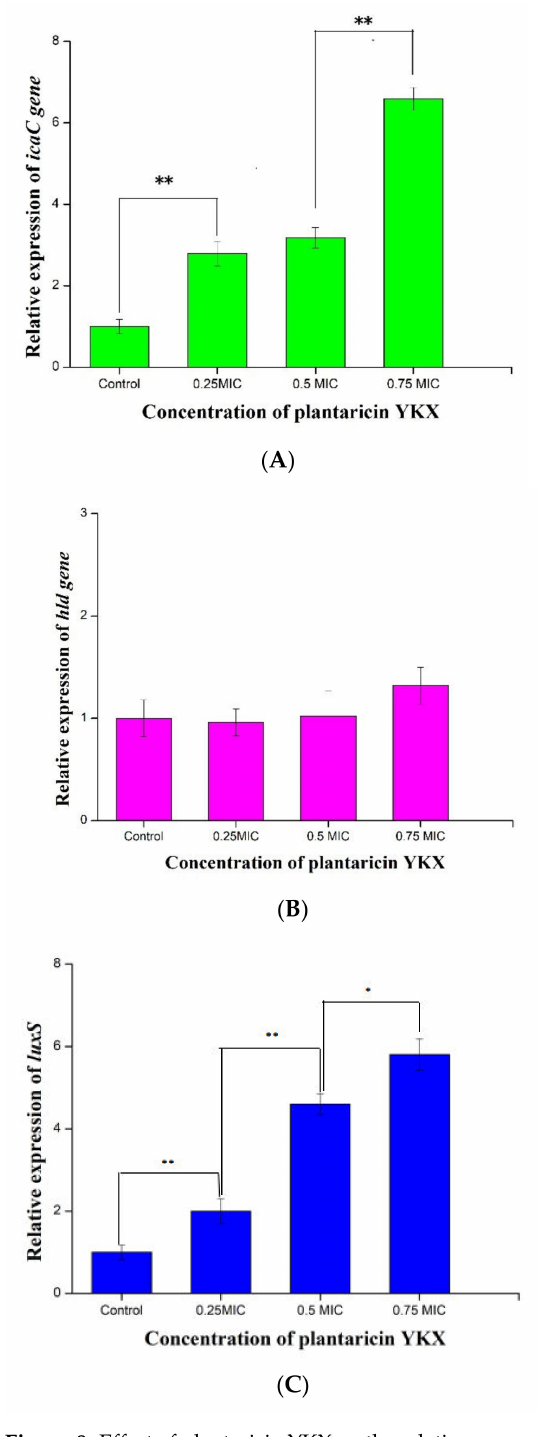
Figure 8. Effect of plantaricin YKX on the relative expression of QS system-related genes. ( A ): icaC ; ( B ): hld ; ( C ): luxS . * significant. p < 0.05; ** highly significant. p <